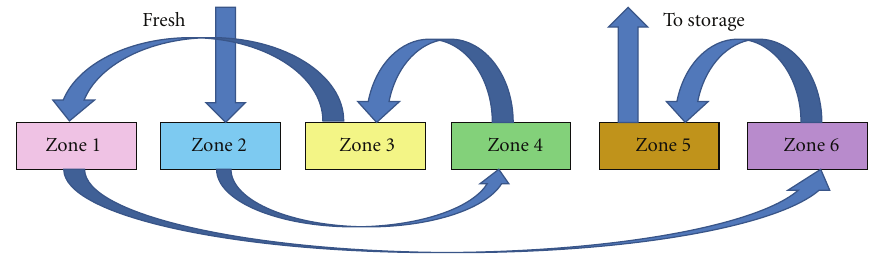
Figure 3: Mixed reshu ffl ing